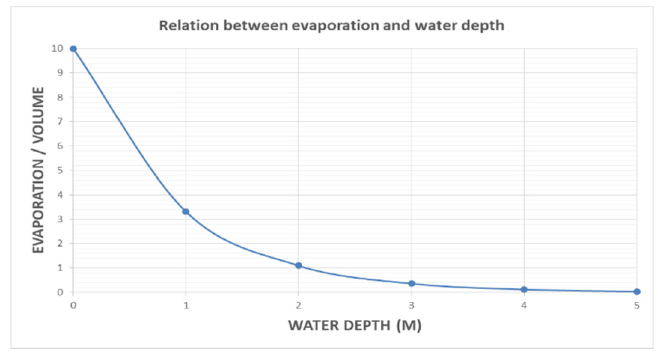
Figure 4. Relation between evaporation and water depth.